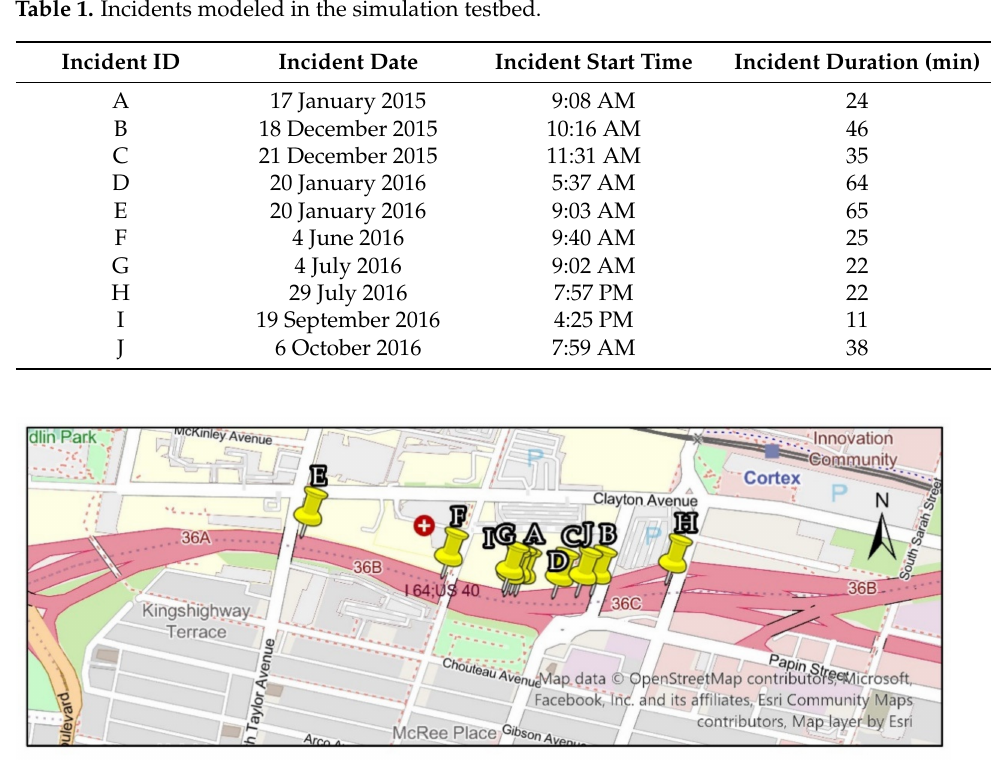
Figure 3. Boundaries of simulation testbed and location of